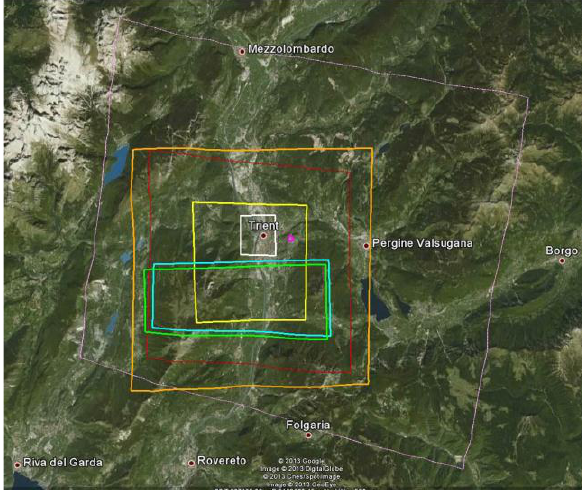
Fig. 2. Location of satellite imagery in Trento testfield. Violet: SPOT-5/HRG single scene, orange: Pleiades triplet, red: WV2 stereopair, yellow: GE1 stereopair, blue and green: Quickbird single scenes, white: aerial images, pink: UAV.